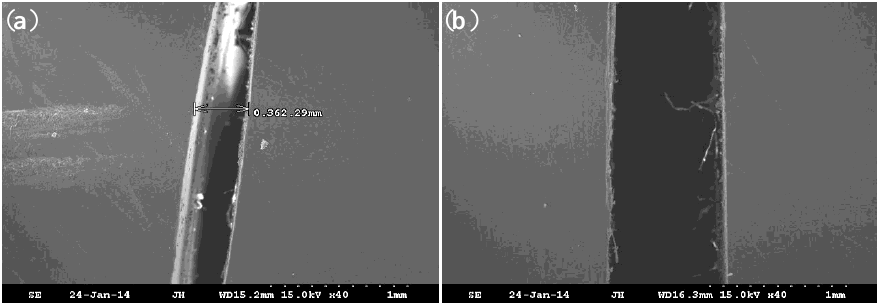
Figure 10. Cross-section pictures of the channel at bonding temperatures of 95 °C ( a ) and 85 °C ( b